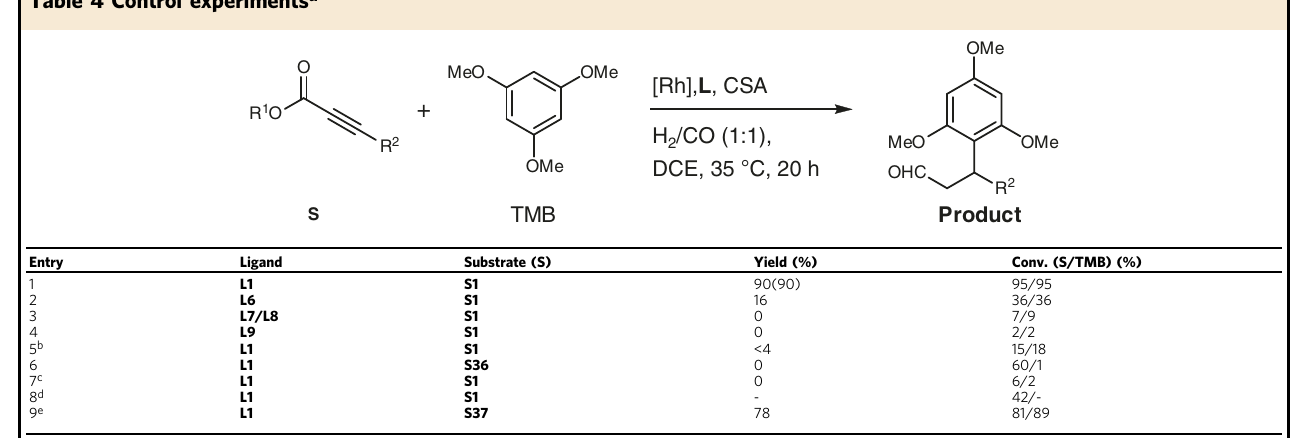
Table 4 Control experiments a